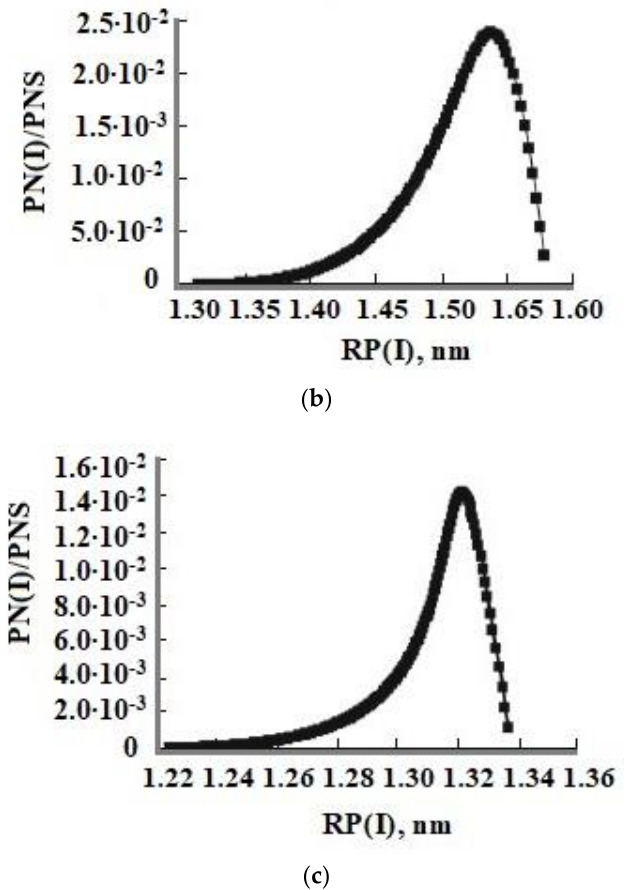
Figure 6. The particle size distribution at different pH and initial OSA concentrations C s . ( a ) T = 50 °C, C s = 700 mg/kg, рН = 4 ; ( b ) T = 50 °C, C s = 700 mg/kg, рН = 8 ; ( c ) T = 60 °C, C s = 800 mg/kg, pH = C s = 700 mg/kg, pH = 4; ( b ) T = 50 ◦ C, C s = 700 mg/kg, pH = 8; ( c ) T = 60 ◦ C, C s = 800 mg/kg, 8. PNS — total quantity of the formed SiO 2 particles. pH = 8. PNS—total quantity of the formed SiO 2